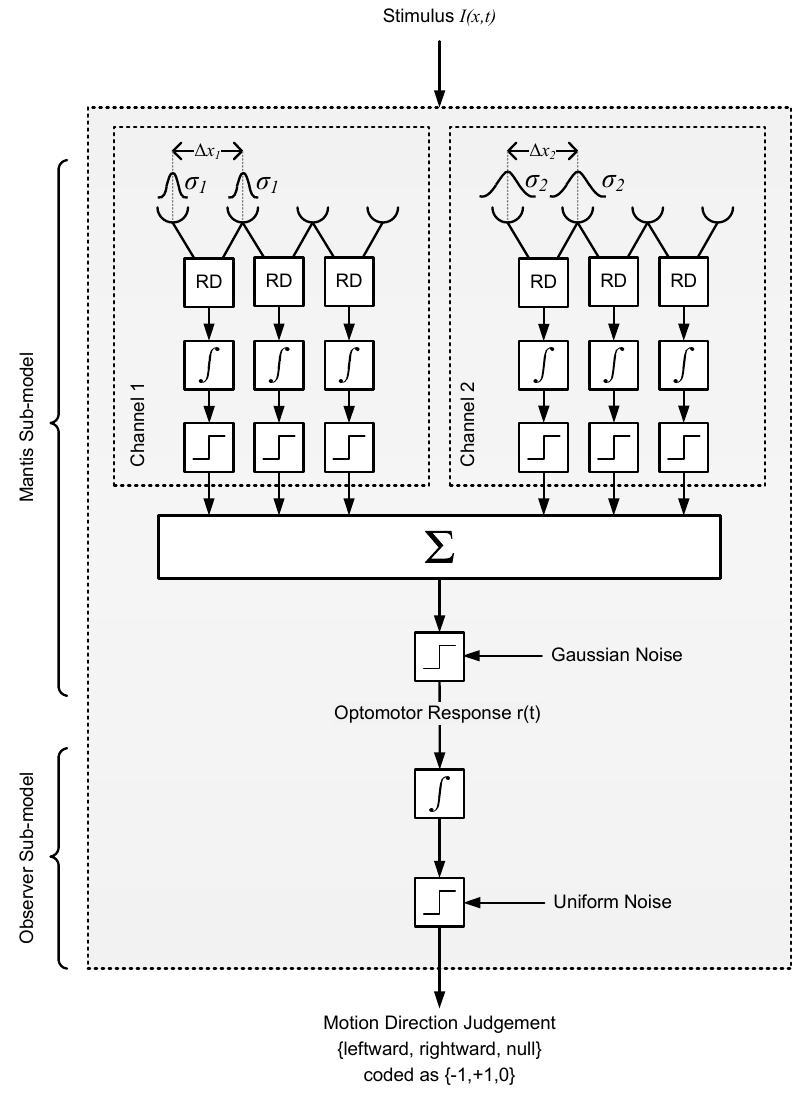
Figure 9. Optomotor response model based on the Reichardt Detector (Model 2). The model has two arrays of detectors that are positioned in random locations across a simulated 1D retina. Detectors within each array share the same subunit separation and spatial filter extent (and are thus all tuned to the same spatial frequency). Having two detector classes enables the model to respond to stimuli across a range of spatial frequencies broader than that of a single detector. The output of each detector is temporally integrated and then converted to a “vote” for leftward, rightward, or no motion by a hard threshold. The votes are subsequently combined, thresholded, and then passed through another temporal integrator and hard threshold blocks that model the decision process of the human observer in the